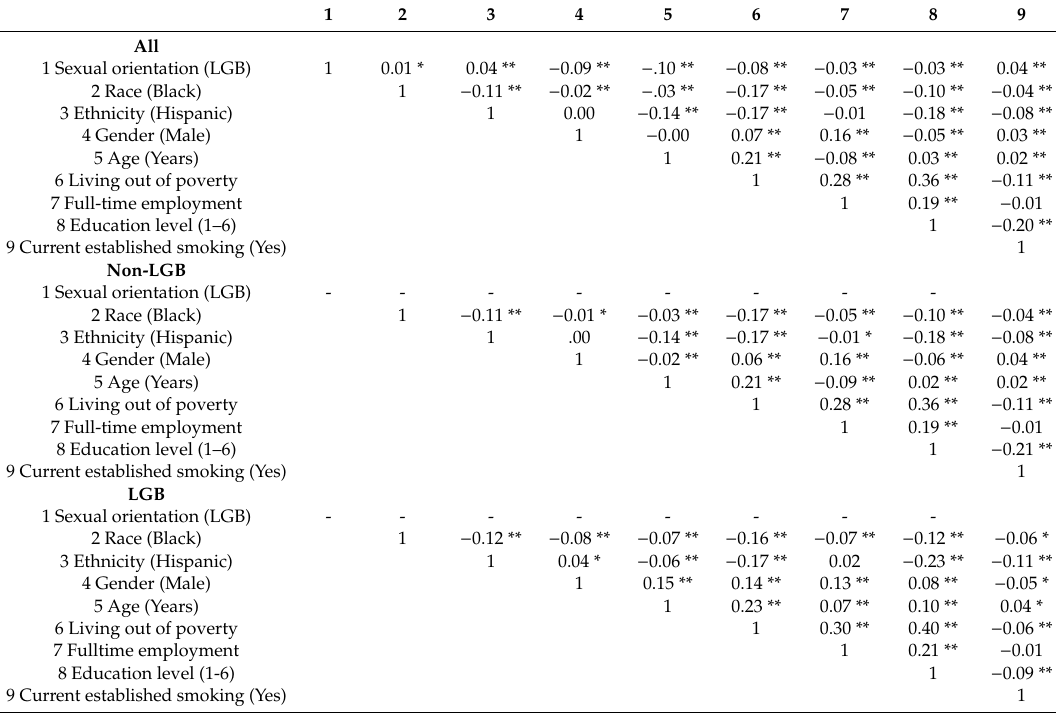
Table 2. Bivariate correlations.